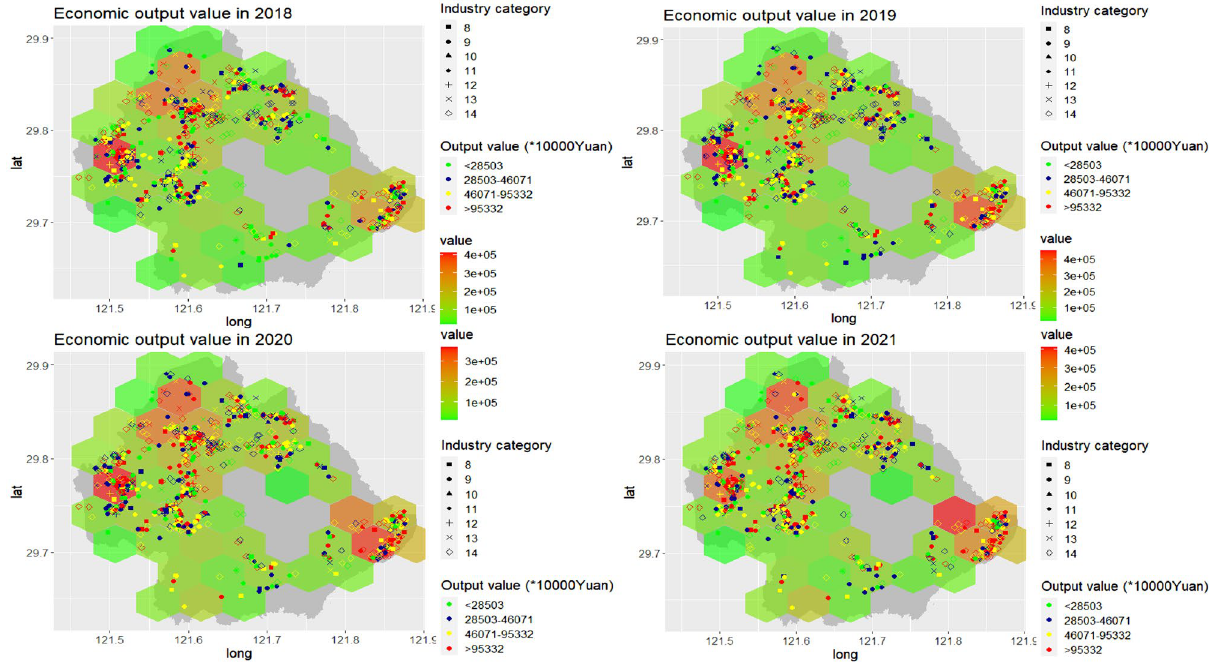
Figure 1. The spatio-temporal distribution of economic output value in Yinzhou, 2018–2021 (Industry category: 8 (motorcar), 9 (high-level equipment), 10 (new materials), 11 (intelligent home electrics), 12 (key fundamental part), 13 (fashion and clothes), 14 (new service and others)).